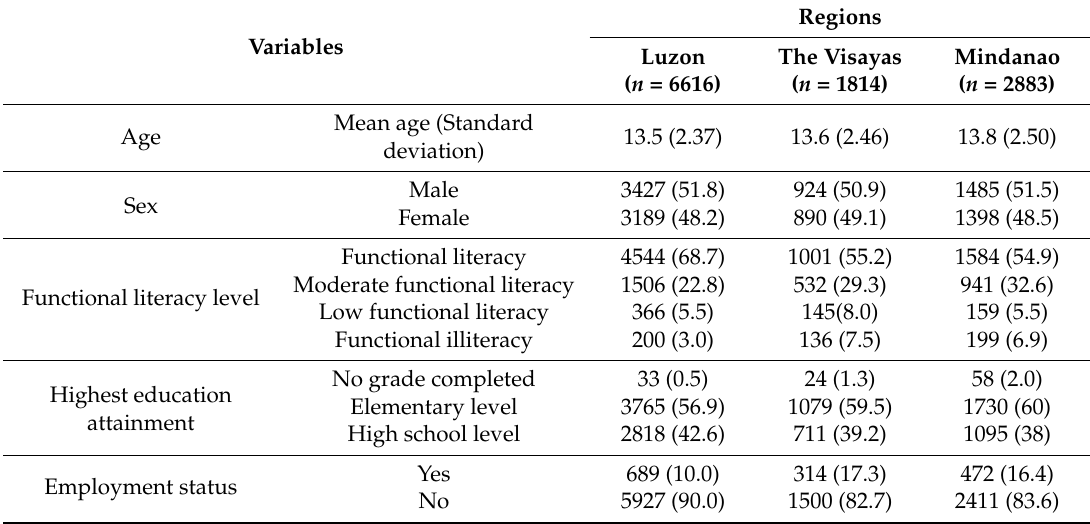
Table 1. Demographic characteristics of school-aged children, stratified by regions of the Philippines.